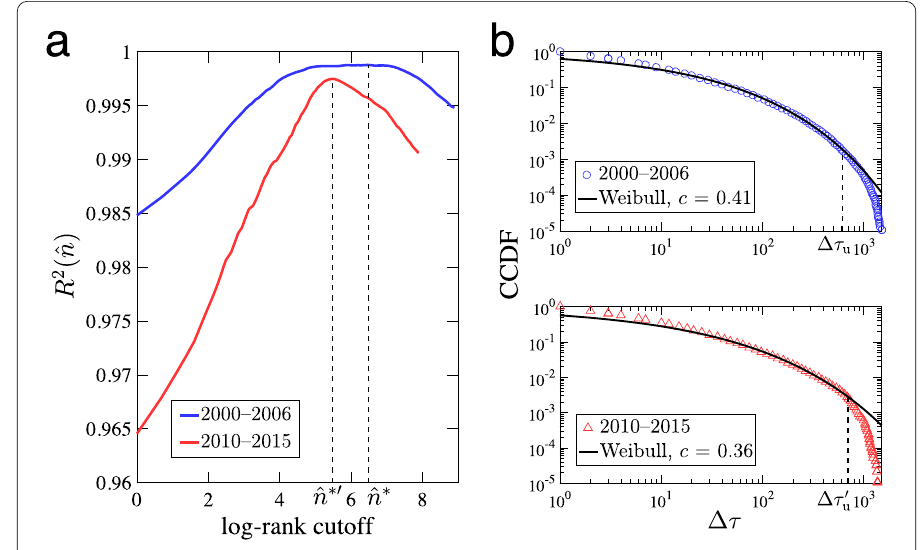
Figure 7 Fitting of the interval distribution with a Weibull distribution. ( a ) Determination of the optimal log-rank cutoff ˆ n ∗ . ( b ) Empirical CCDF of interval (cid:4)τ (symbols) and the Weibull distribution with the estimated parameters (lines). The cutoffs (cid:4)τ u and (cid:4)τ (cid:18) u are obtained from the optimal log-rank cutoffs ˆ n ∗ and ˆ n ∗(cid:18) ,